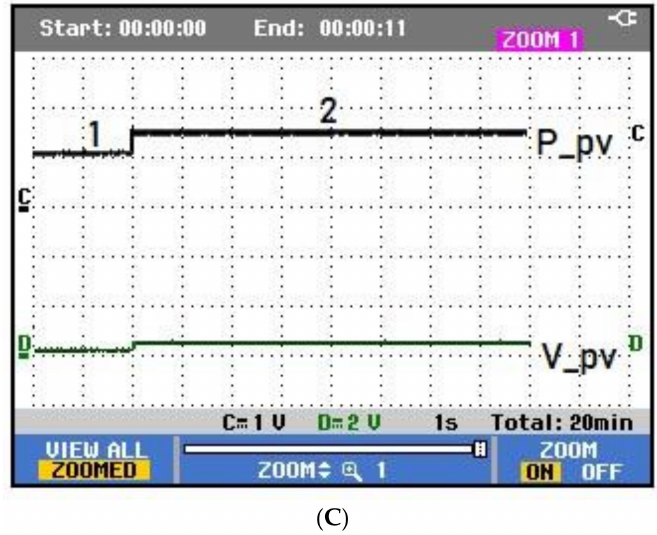
Figure 24. ( A ) Output power and voltage with MDOF-FLC under constant atmospheric conditions (T = 25 ◦ C, G = 1000 Watt/m 2 ). ( B ) Output power and voltage with SUIPID under constant atmo- spheric conditions (T = 25 ◦ C, G = 1000 Watt/m 2 ). ( C ) Output power and voltage with FLC under constant atmospheric conditions (T = 25 ◦ C, G = 1000 Watt/m 2 ).